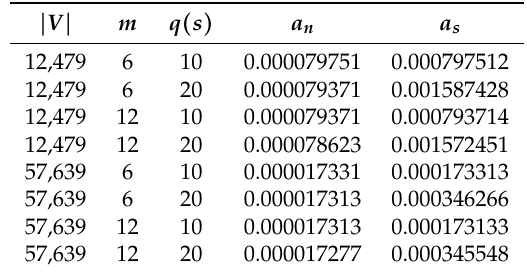
Table 2. Summary of attractiveness values used during network simulations in Communities (first four rows) and VirtualTourist (last four rows). | V | is the number of nodes, m the number of mermaids, q ( s ) is the weight assigned to mermaids, a n is the attractiveness of normal nodes, and a s is the attractiveness of mermaids.